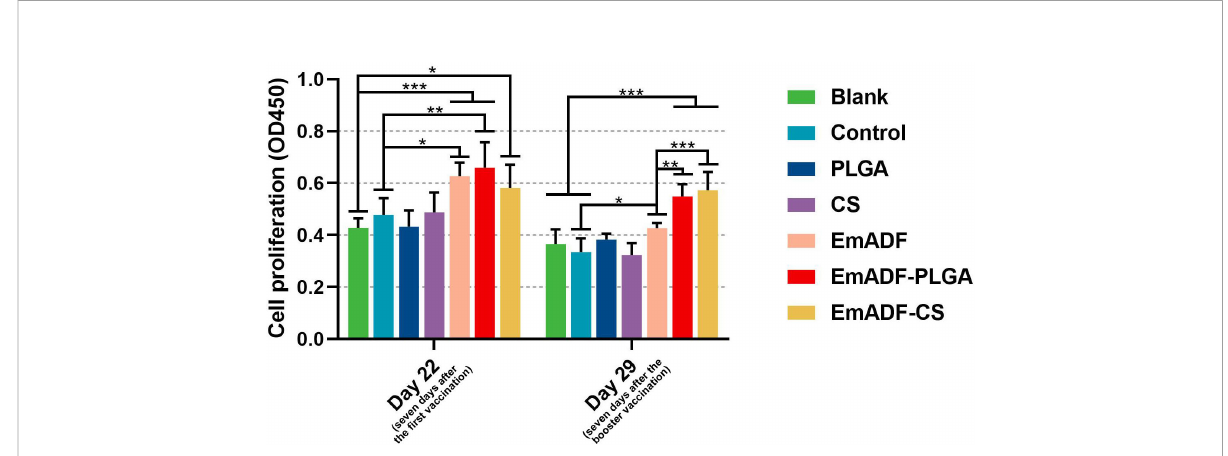
FIGURE 7 The proliferation of chickens ’ lymphocytes. Chickens in each group were sacri fi ced, and the lymphocytes was collected. The proliferation of lymphocytes was then determined by CCK-8 reagent. Each group involved fi ve biological replicates, and each replication was detected once. Values were estimated using one-way ANOVA analysis followed by Dunnett ’ s test. Comparisons among EmADF, EmADF-PLGA, and EmADF-CS group were conducted by ANOVA following Bonferroni ’ s correction. Values were presented as the mean of the mean ± SD. * p< 0.05, ** p< 0.01, and *** p< 0.001.